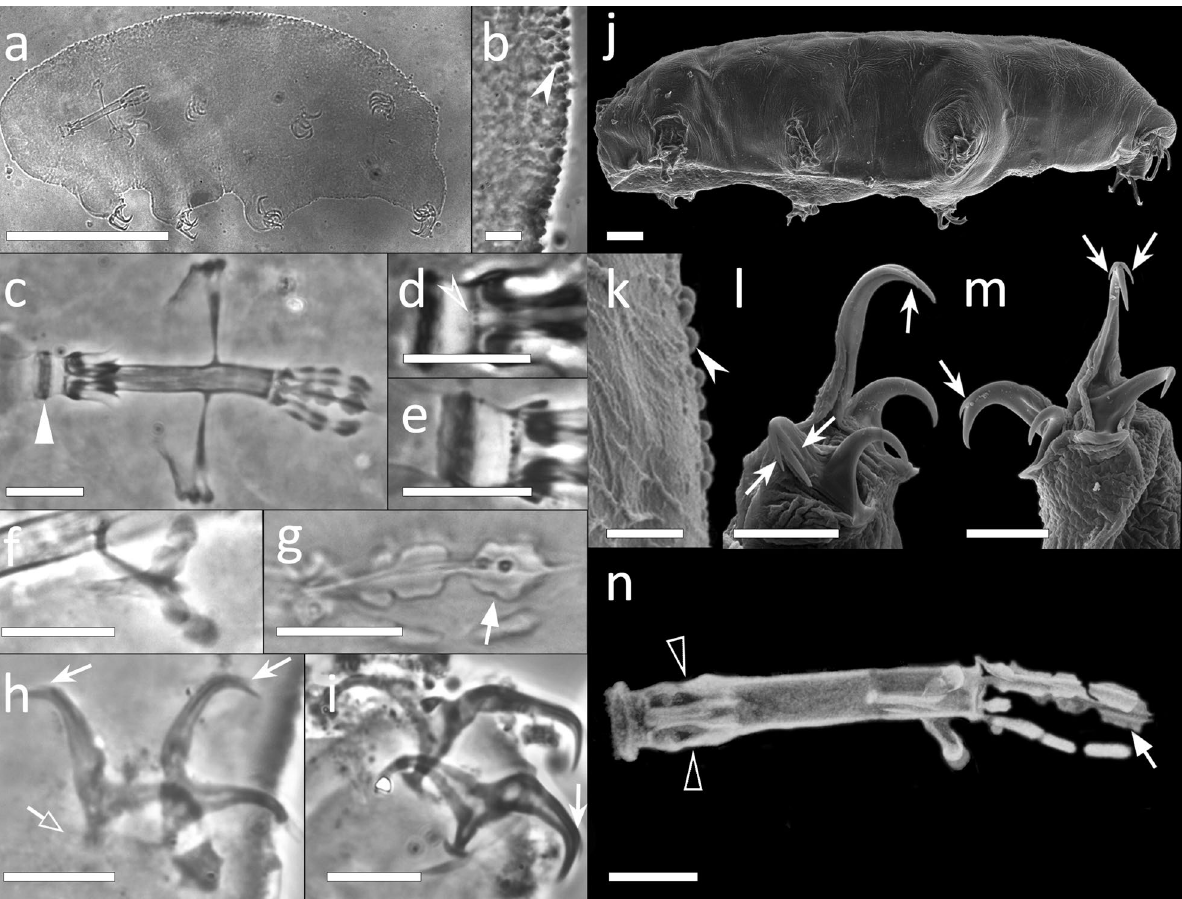
Figure 6. Thulinius gustavi sp. nov. ( a ) In toto (dorso-lateral view), ( b ) Cuticular ornamentation (dorso-lateral view), ( c ) Bucco-pharyngeal apparatus (dorso-ventral view from multiplanar images stack), ( d ) Buccal armature (dorsal view), ( e ) Buccal armature (ventral view), ( f ) Stylet furca (frontal view), ( g ) Macroplacoids (frontal view from multiplanar images stack), ( h ) Claw I (lateral view), ( i ) Claw IV (frontal view), ( j ) In toto (lateral view), ( k ) Cuticular ornamentation (dorso-lateral), ( l ) Claw II (frontal-lateral view), ( m ) Claw IV (frontal view), ( n ) Bucco-pharyngeal apparatus (3D lateral reconstruction). Indented arrowheads: cuticular ornamentation; white arrowhead: peribuccal lamellae; empty indented arrowhead: posterior line of small round teeth; white arrow: second macroplacoid constriction; white indented arrows: accessory points of the main claw branch; empty arrow: pseudolunules; empty arrowheads: apophyses for the insertion of the stylet muscles. ( a–c ) Holotype. ( a–f ), ( h,i ). LM, PhC; ( g ) LM, DIC; ( j–m ) SEM; ( n,o ) CLSM; Scale bars ( a ) 100 µm; ( b – j , n ). 10 µm; ( k ) 2 µm; ( l , m ) 5